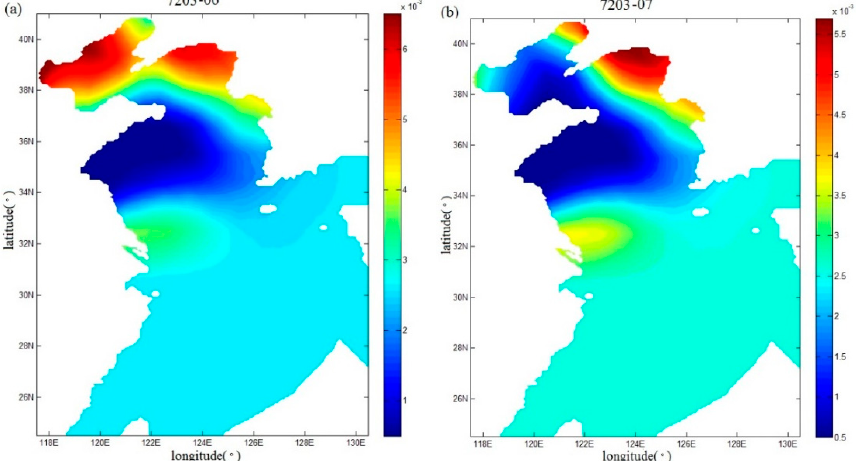
Figure 11. Spatial distributions ( a , b ) of the drag coe ffi cient in the sixth and seventh periods in Case 5 Figure 10. Spatial distributions ( a , b ) of the drag coefficient in the sixth and seventh periods in Case 5 during Typhoon during Typhoon 7203.